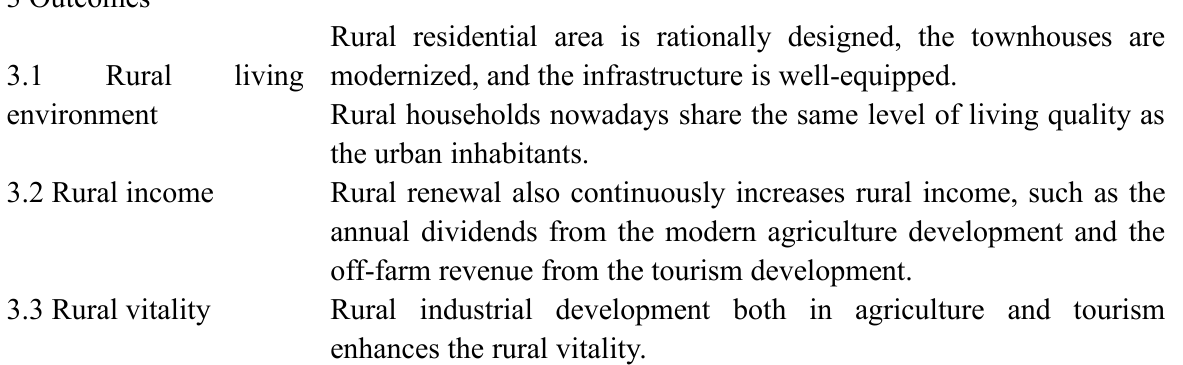
Table A3.7: Archetype 7 Government participation in rural renewal with a large number of rural households involved and a long-term